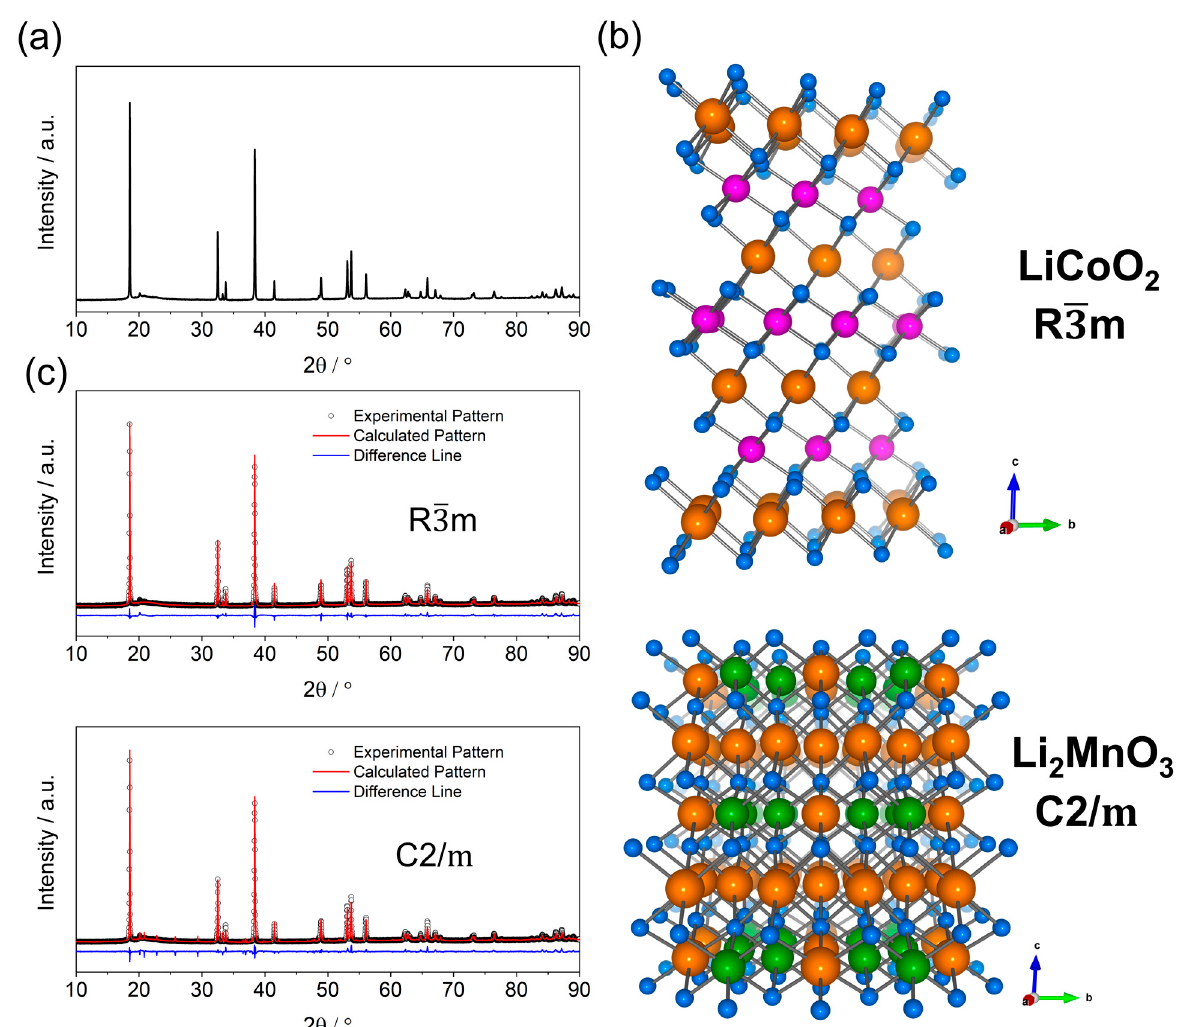
Figure 2. ( a ) XRD pattern of Li 1.2 Mn 0.54 Ni 0.13 Co 0.13 O 2 acquired with a Rigaku SmartLab (Bragg-Brentano geometry, CuK α radiation), ( b ) pictorial structure of LiCoO 2 ( R 3 m symmetry; ICSD: 74330) and Li 2 MnO 3 ( C 2/ m symmetry; ICSD: 165686) where Li and metals layers can be seen. Lithium is orange, Co is pink, Mn is green, and O is blue. ( c ) Rietveld refinement, obtained with GSAS-II of XRD pattern, assuming R 3 m or the C 2/ m symmetry.